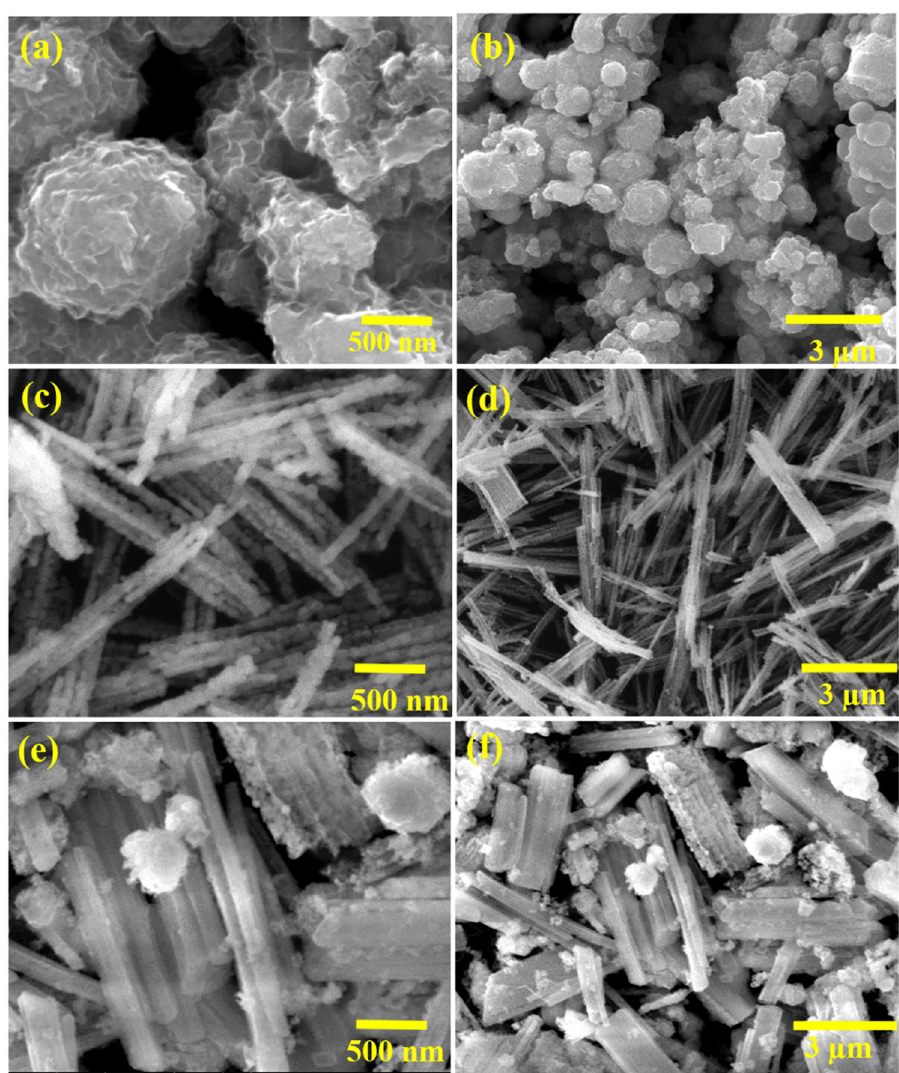
Figure 2. FE-SEM images of ( a , b ) MoSe 2 , ( c , d ) NiO nanorods and ( e , f ) NiO/MoSe 2